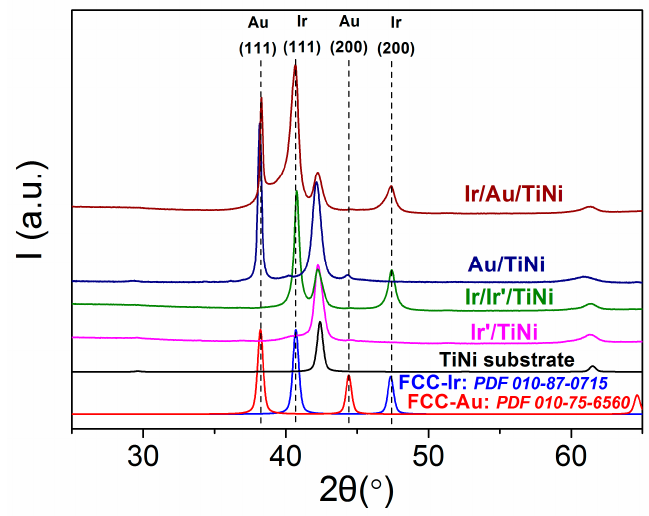
Figure 3. XRD patterns of noble metal films on TiNi substrates.